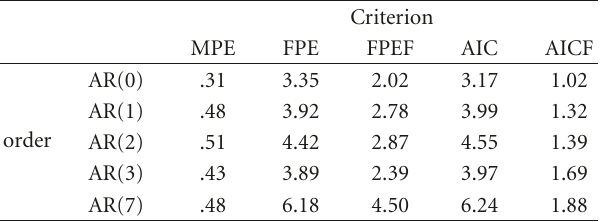
Table 1: Mean of prediction error for several order selection criteria.